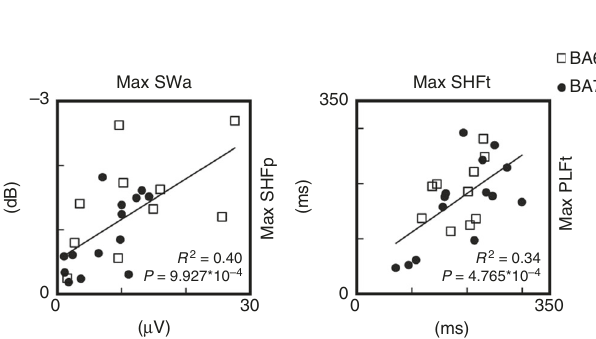
Fig. 2 TMS evokes an OFF-period at all targeted sites and irrespective of pre-stimulus activity. a White crosses on the structural MRI indicate the cortical TMS targets (BA6-frontal/BA7-parietal and left/right) in patient 15. For each cortical target, butter fl y plots of the TMS-evoked EEG potentials recorded from all 60 channels (gray traces) are shown. The electrode with the largest TMS-evoked EEG potential is highlighted (black trace) and the corresponding ERSP is presented. The dashed horizontal line marks the 20 Hz frequency bin and the dashed vertical line indicates the occurrence of TMS. b EEG activity (one representative electrode -Cz- re-referenced to the mathematically linked mastoids) recorded in patient 4 while TMS was delivered with an inter- stimulus interval randomly jittering between 5000 and 5300 ms. Empty squares and stars indicate TMS pulses delivered over an ongoing activity showing (stars) or not showing (empty squares) spontaneous slow waves. c Similar to b , the empty square and the star indicate trials in which TMS pulses were delivered over an ongoing activity, respectively, showing or not showing spontaneous slow waves. d The same trials shown in c are superimposed and averaged (red lines) for both conditions. The corresponding ERSPs are shown in the bottom panels